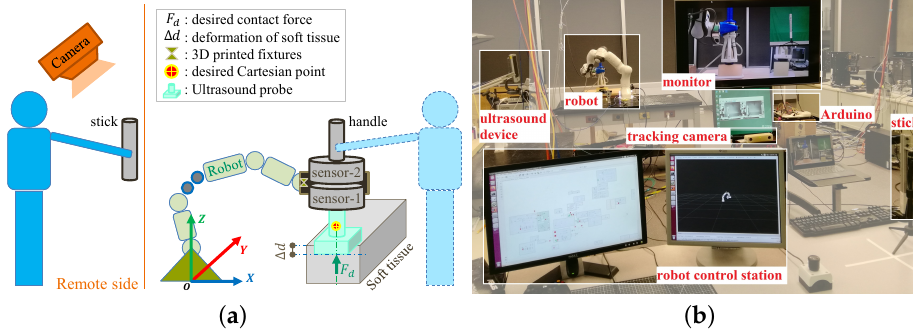
Figure 1. Schematic setup and real scene for the proposed dual-mode p HRI- tele HRI control system. Note that sensor-1 and sensor-2 are external force/torque sensors of the same type, and they are stacked and installed by using a specially designed fixture to ensure that the two sensors work in- dependently without affecting each other. In p HRI mode, the user can directly apply force on the handle attached at the robot EE in order to move the robot EE. In tele HRI mode, the user will hold and move the stick in order to move the robot EE while the stick pose is tracked by a tracking camera in real time. ( a ) Schematic setup. ( b ) Real